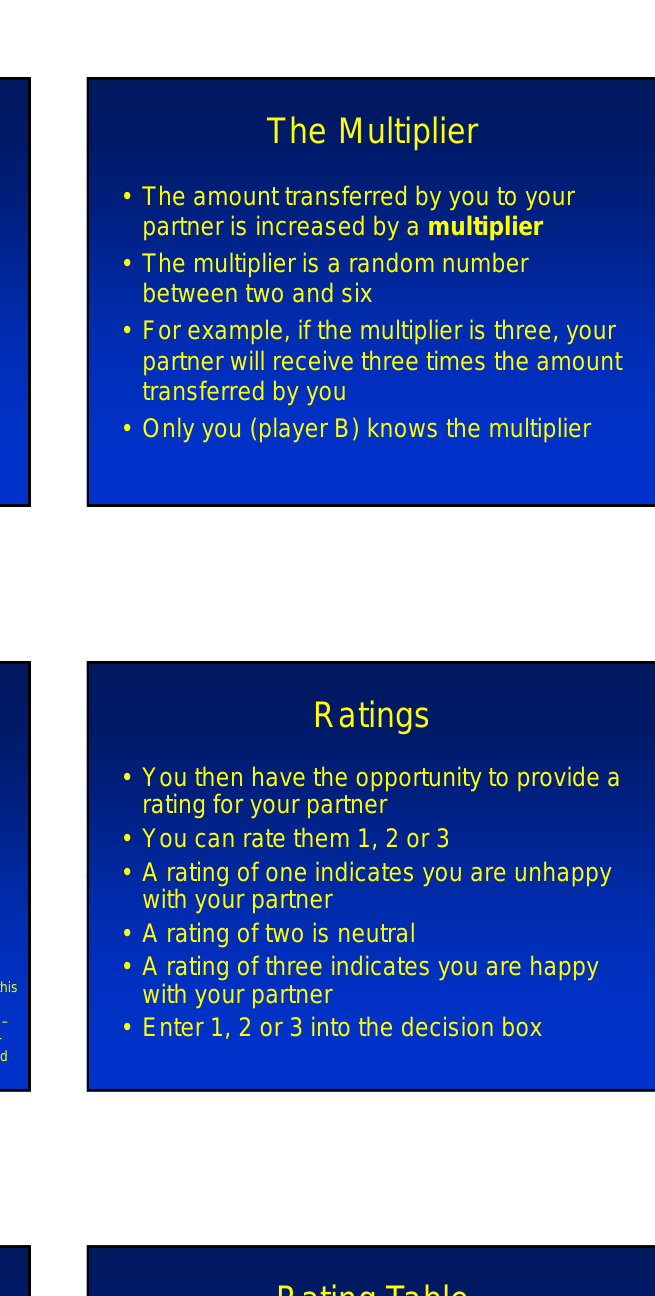
The rating table shows how each player was rated by their partner, and who that partner